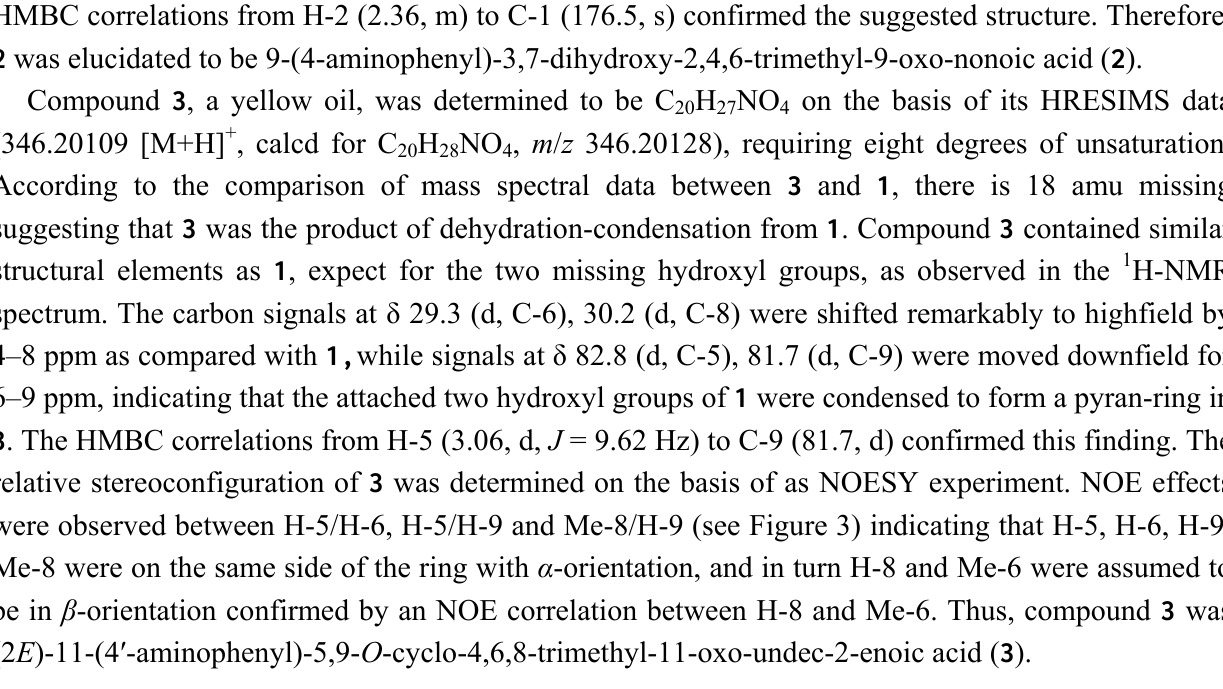
Figure 3. Key NOE correlations of compound 3